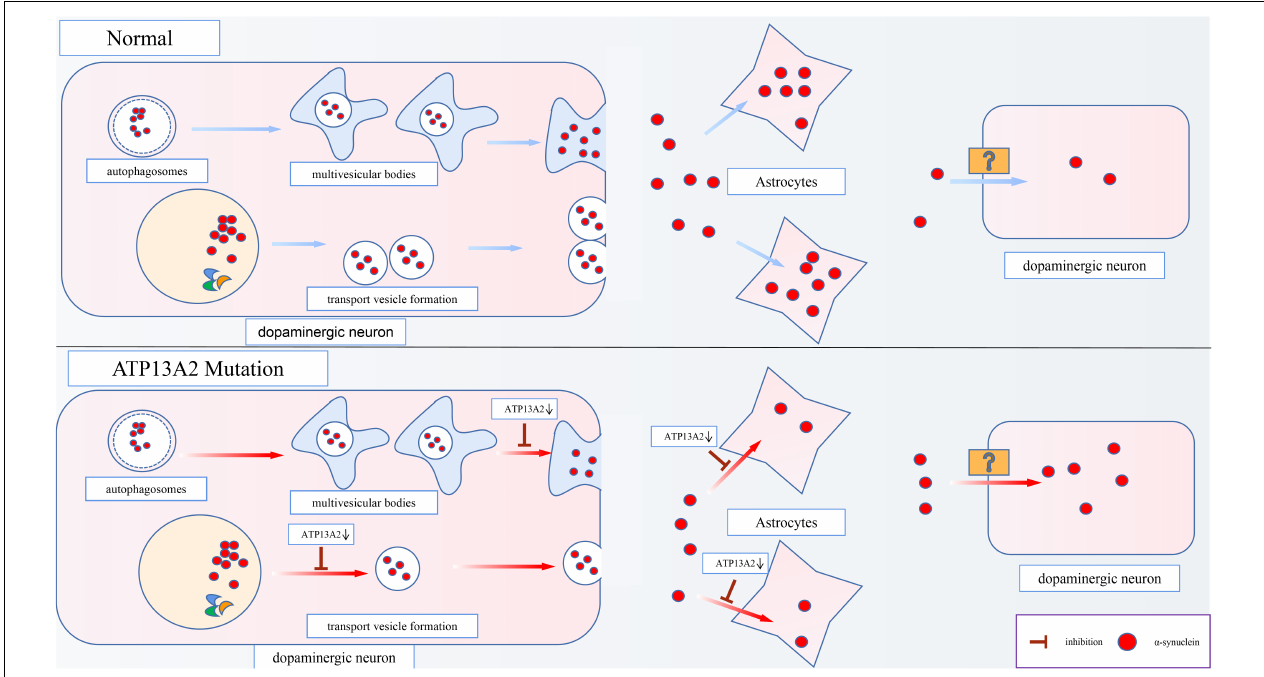
FIGURE 3 | Effects of ATP13A2 gene mutation on extracellular clearance of α -synuclein. When ATP13A2 protein expression in lysosomes is reduced, lysosomal exocytosis and exosomal secretion of α -synuclein are both inhibited. In addition, a decrease in ATP13A2 protein expression in lysosomes decreases the uptake of α -synuclein by astrocytes, resulting in increased α -synuclein transfer between dopaminergic